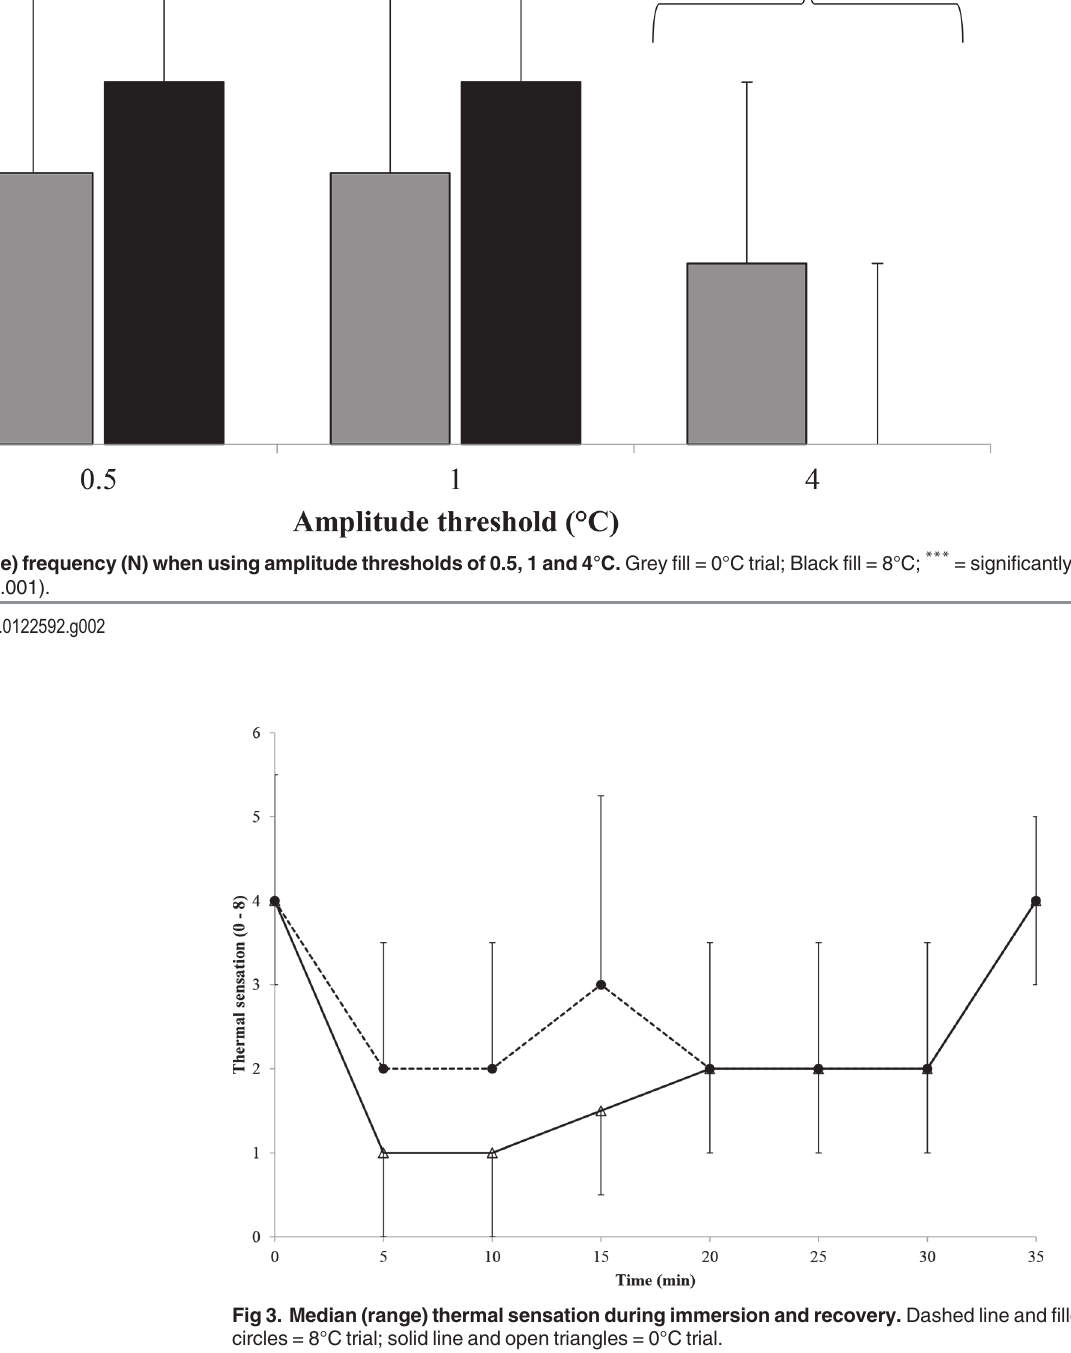
PLOS ONE | DOI:10.1371/journal.pone.0122592 April 17,